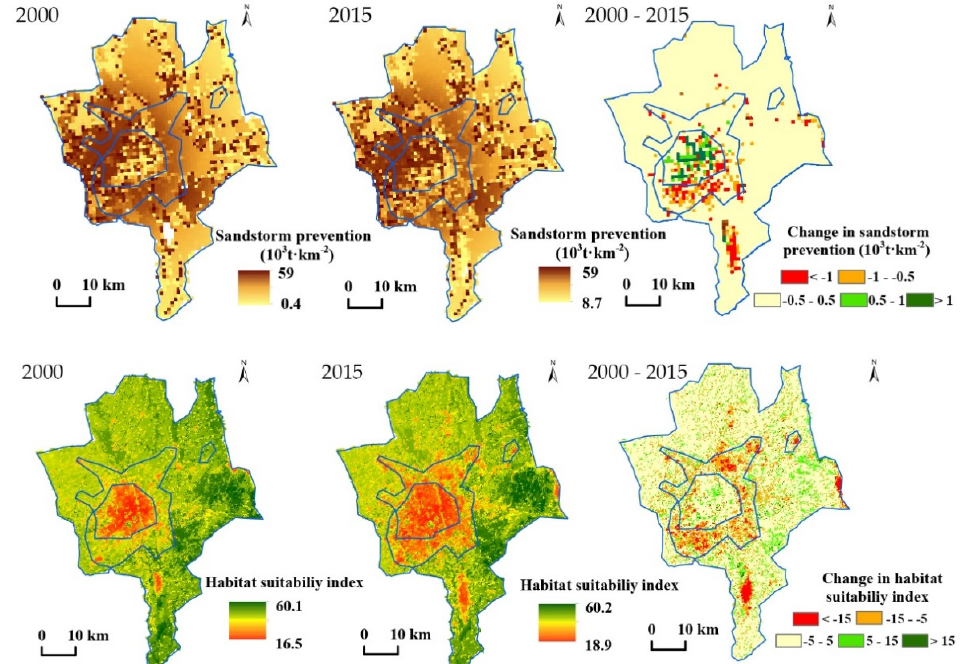
Figure 3. Spatial Distribution of ESs in 2000, 2015, and changes of Changchun.